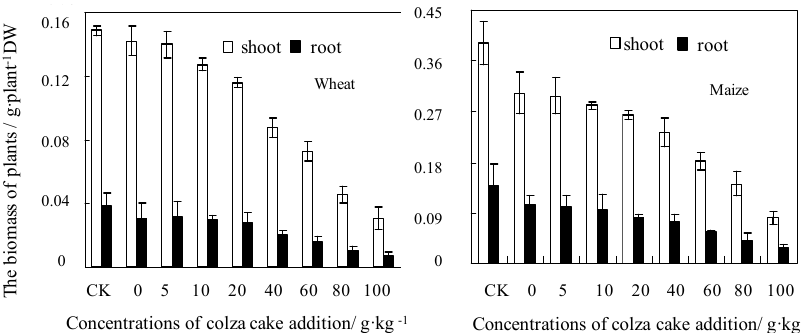
Figure 3. Effects of colza cake addition on the biomass (expressed as dry weight) of wheat and maize in Cd-contaminated soils.